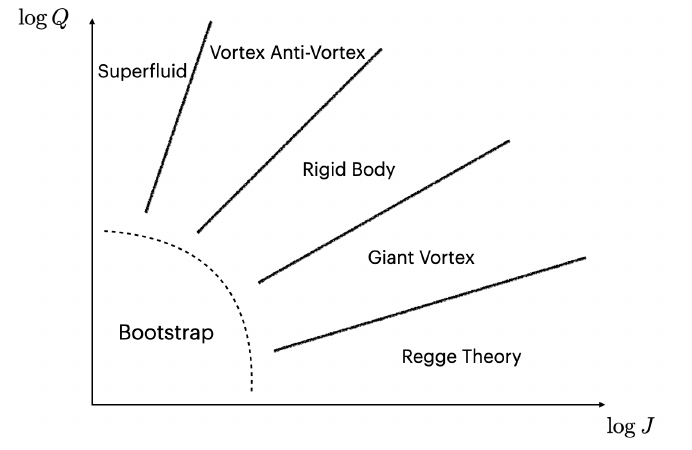
Figure 1 . Phase-diagram for the ground-state on R × S 2 ; the small Q and J regime is accessible via the numerical